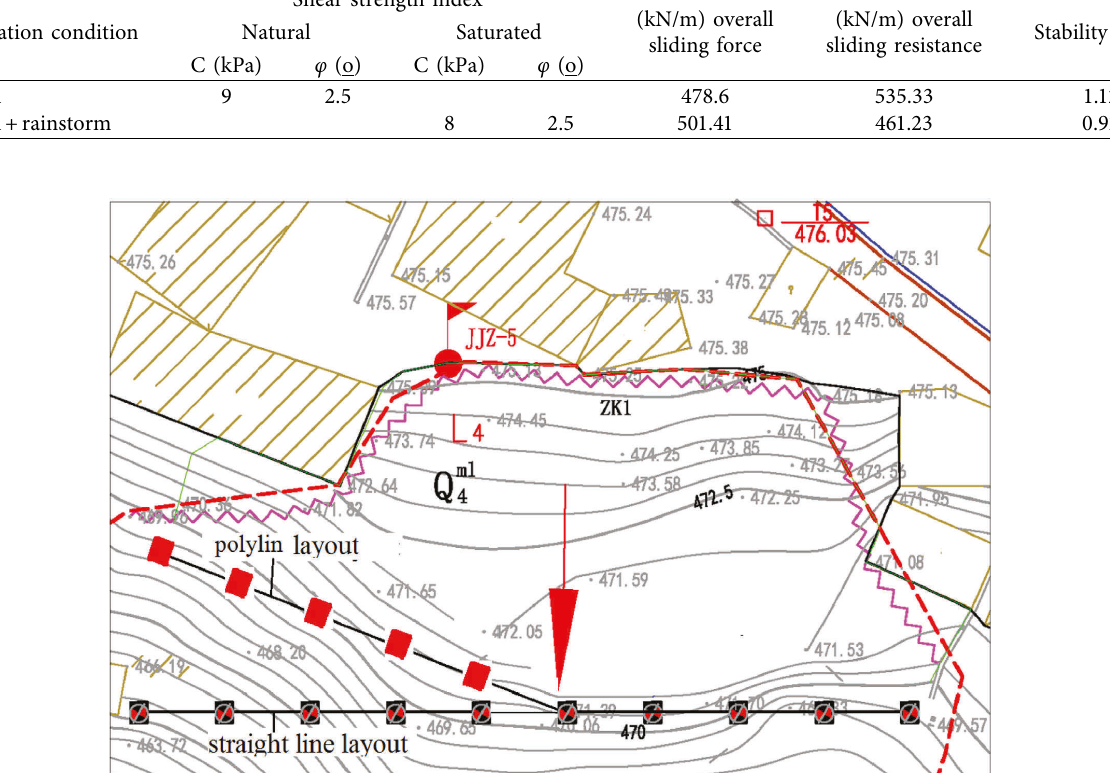
Figure 19: Plane layout of antislide piles arranged in a straight line and in a